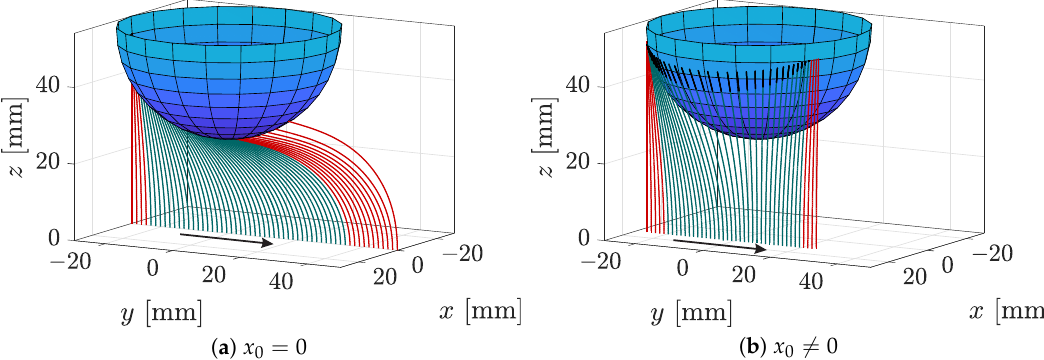
Figure 7. Simulated sequence of elastic lines during two scanning sweeps along a 60 mm sphere (red—tip contacts, green—tangential contacts, black—undeformed end of the wire.